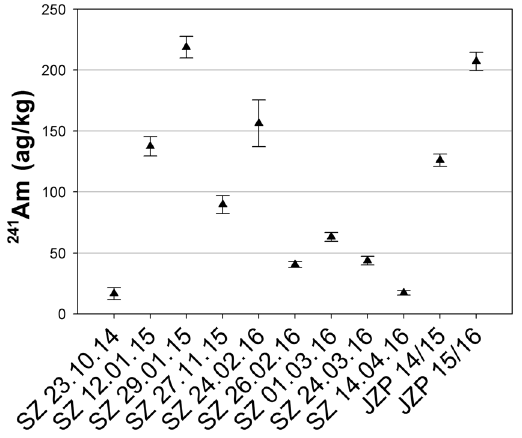
Figure 5. 241 Am concentrations in the snow samples. The error bars indicate expanded uncertainty (k = 2). SZ: freshly fallen snow Zugspitze, JZP: naturally accumulated